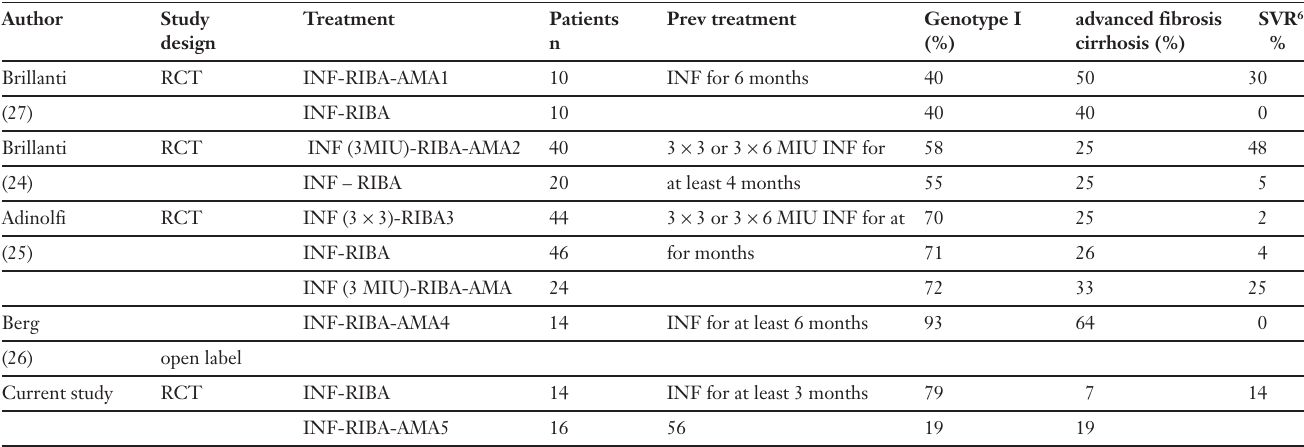
Table 3 Summary of the most important findings from the studies published as full papers investigating the effect of triple therapy in interferon monotherapy non-responders and the current study.